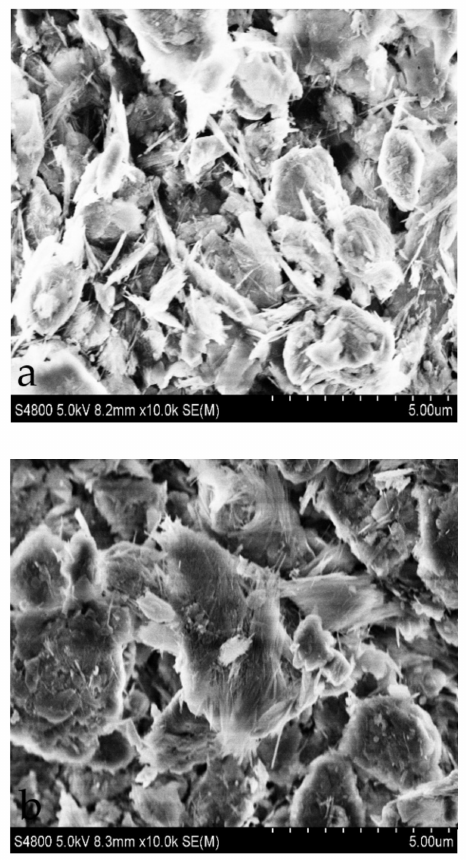
Figure 3. SEM image of original sepiolite ( a ) and modified sepiolite ( b